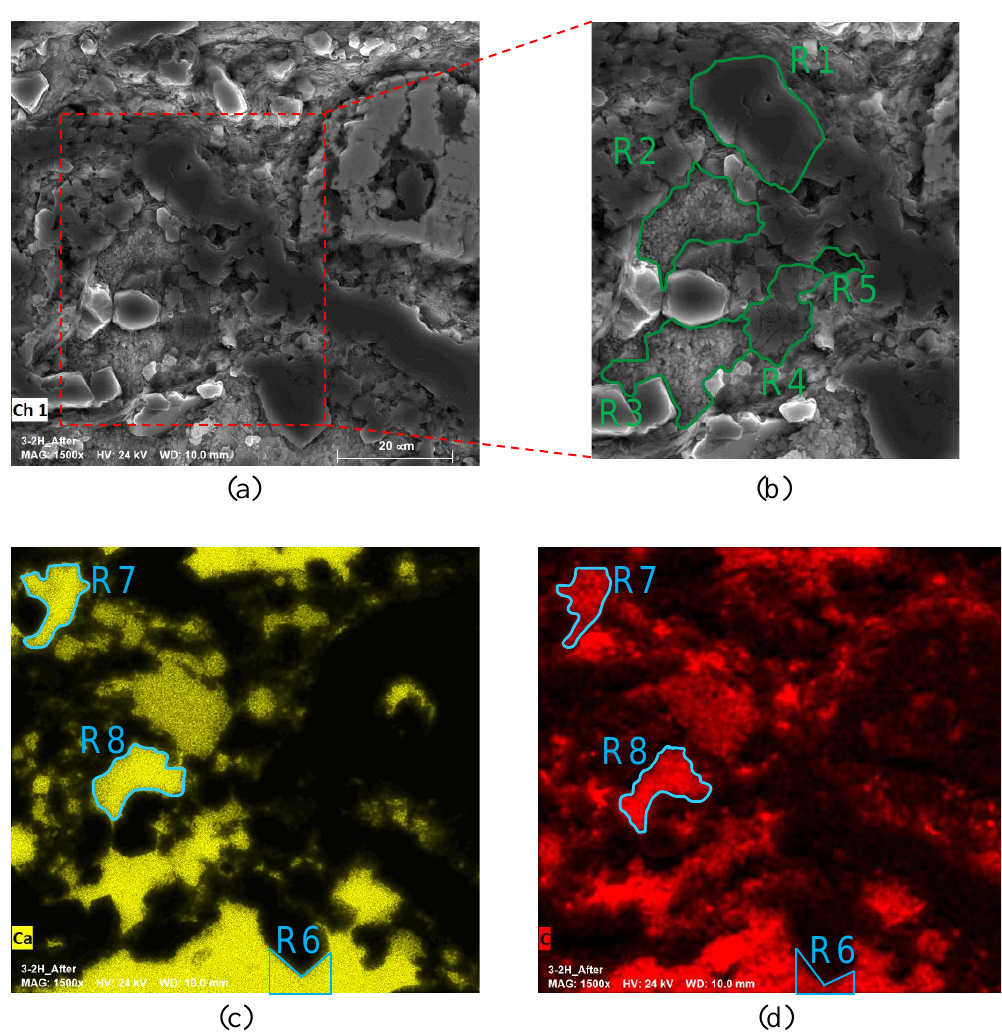
Figure 16. BSE images and EDS maps of a region with different patterns of etching/dissolution ( a , b ) BSE images of this region with different patterns of calcite alteration; ( c , d ) EDS maps for calcium and carbon in the region associated with Figure 16a.